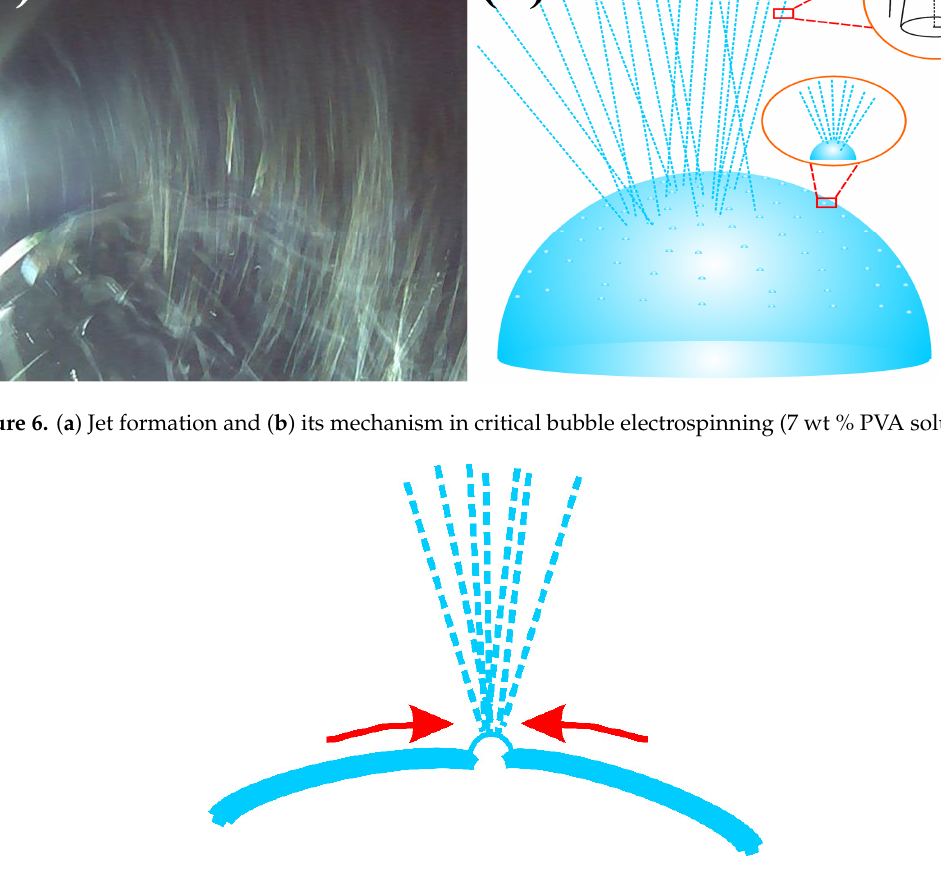
Figure 7. The flow around a sub-daughter bubble during the generating jets process.